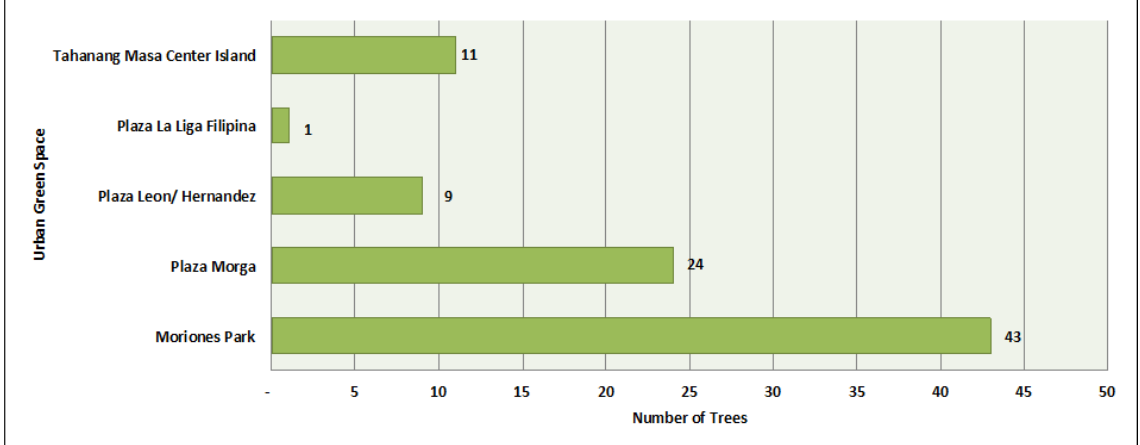
Figure 3. Numberof inventoried trees in District 1, Manila City, Philippines